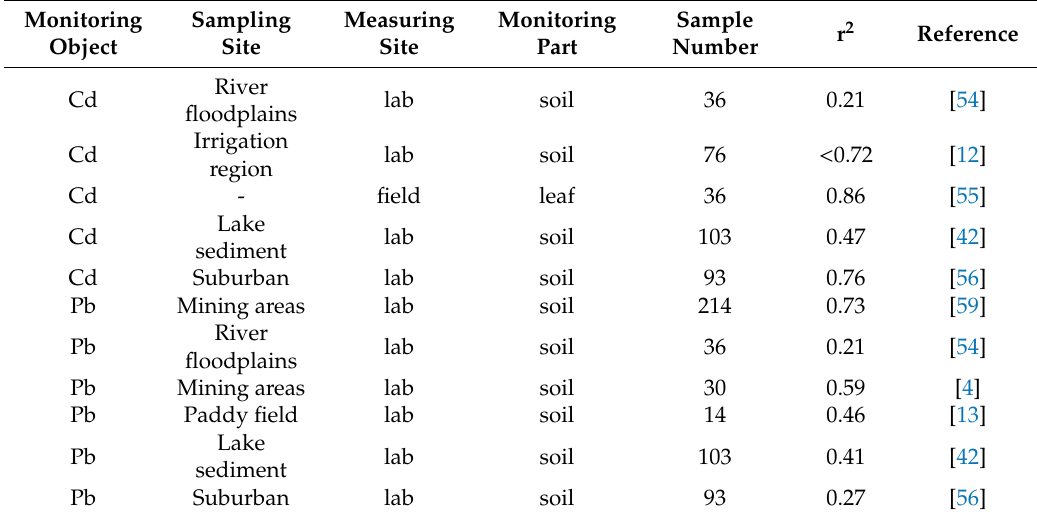
Table 7. Predicted accuracies of using visible and near-infrared reflectance spectroscopy (VNIRS) based on PLSR for recent